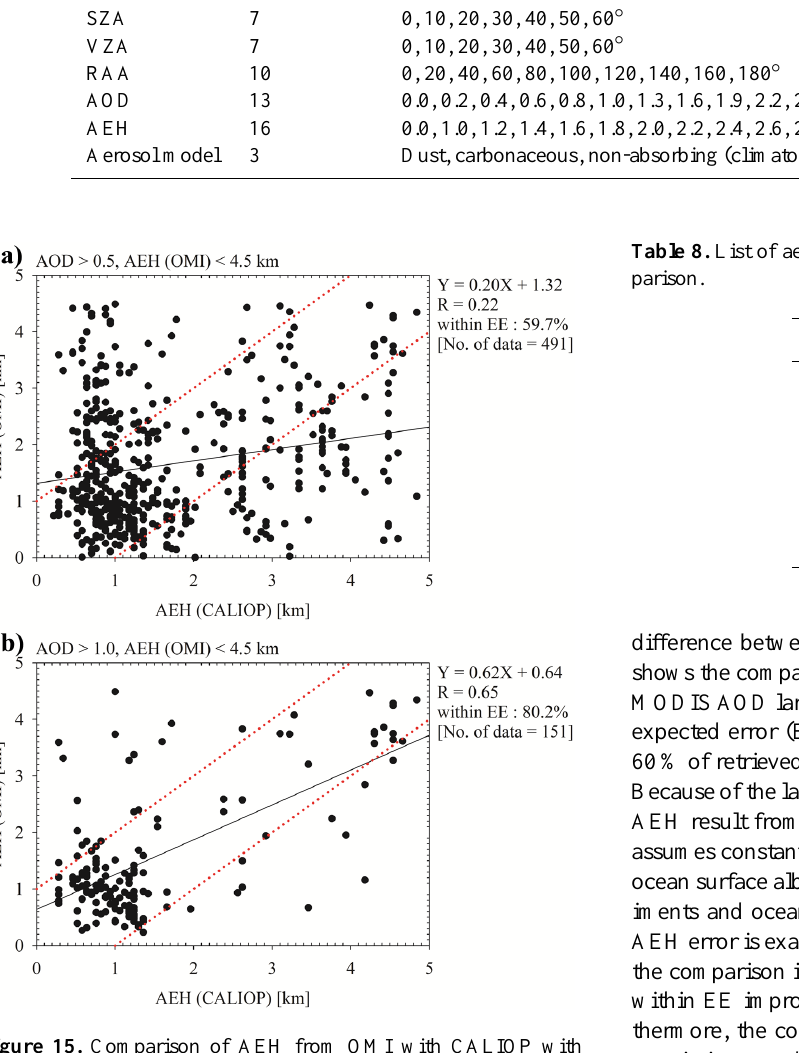
Figure 15. Comparison of AEH from OMI with CALIOP with (a) AOD>0.5 and (b) AOD>1.0 for aerosol transport cases in 2007 and 2008 over East Asia.